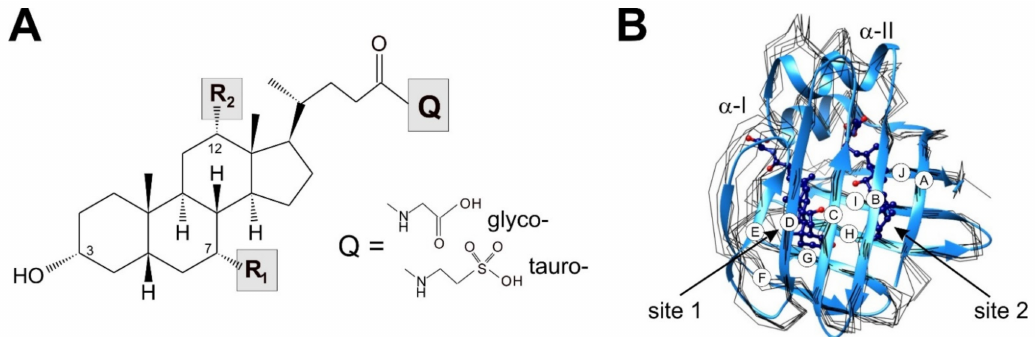
Figure 1. ( A ) Chemical structure of physiologically relevant bile acids differing in the hydroxylation pattern of the steroid rings (R 1 = OH, R 2 = OH cholic acid; R 1 = OH, R 2 = H chenodeoxycholic acid; R 1 = H, R 2 = OH deoxycholic acid) and the type of side-chain conjugation (glycine, taurine). ( B ) Backbone traces (black) of superimposed crystal structures of six BABPs ( apo form) available in the PDB database (human ileal, PDB: 5l8i [19]; zebrafish ileal, PDB: 3elx [20]; human liver, PDB: 3stn [21]; chicken liver, PDB: 1tvq [22] and 7o0j [23]; toad liver, PDB: 1p6p [24]). In cases when more than one molecule is in the asymmetric unit, chain A is shown. For comparison, the ribbon diagram of the most representative element of the NMR-derived lowest-energy structural ensemble of holo human I-BABP (PDB: 2mm3 [25], blue) is shown with bound GCDA and GCA at site 1 and 2, respectively. β -strands are labeled A-J for identification when discussed in the